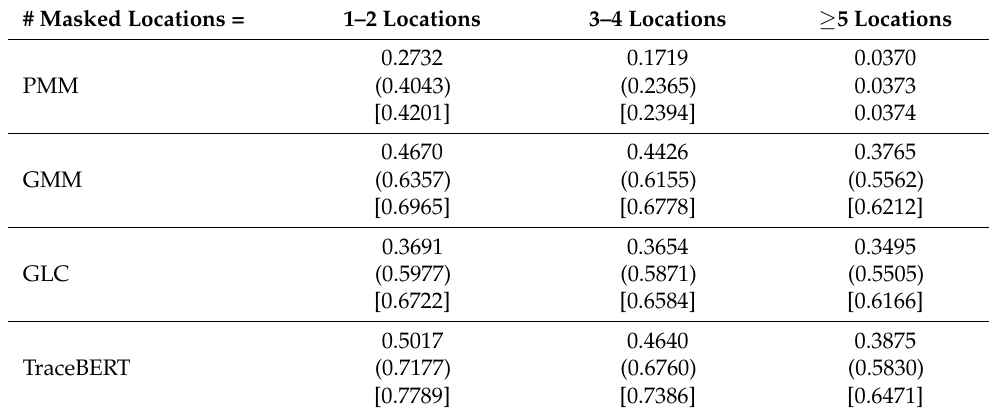
Table 4. Comparison of top-1 accuracy, top-3 accuracy (in round brackets), and top-5 accuracy (in square brackets) for different amounts of masked locations per segment.